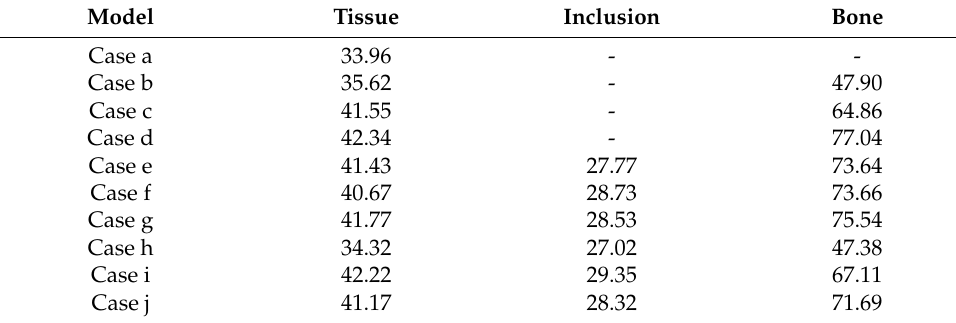
Figure 4. Temperature distributions (unit: ◦ C) in the composite system at the end of the ultrasound diathermy (Cases ( a – j )). Table 3. Peak temperatures in different materials under ten simulation